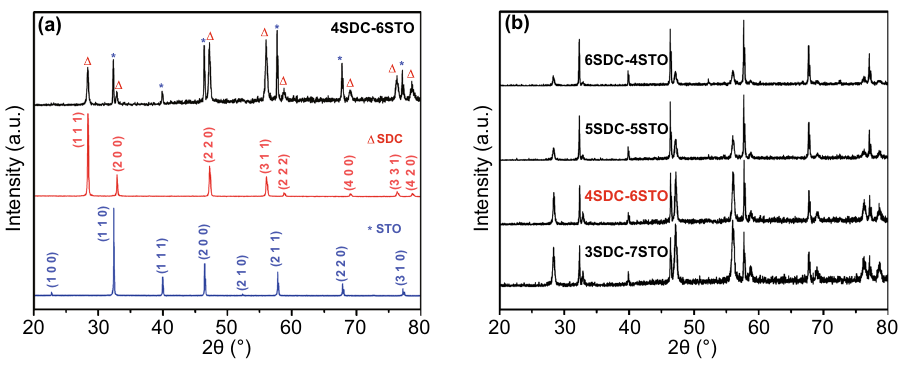
Fig. 1 a XRD patterns of the prepared 4SDC–6STO bulk-heterostructure in comparison with single SDC and STO. b XRD patterns of four SDC–STO samples with various